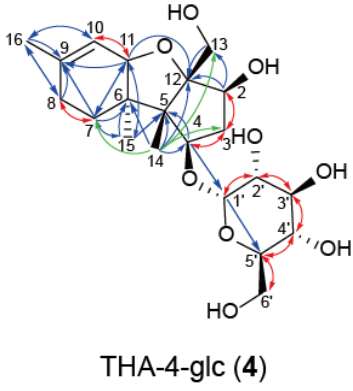
Figure 8. Determination of the structure of 4 . A C-8 unoxygenated d-type trichothecene glucoside conjugate, 1 , was completely converted to an apotrichothecene glucoside conjugate, 4 , by incubating for 21 d at pH 2. The red, blue, and green arrows indicate 1 H– 1 H correlation spectroscopy (COSY), heteronuclear multiple bond coherence (HMBC), and nuclear overhauser effect (NOE) correlations, respectively.